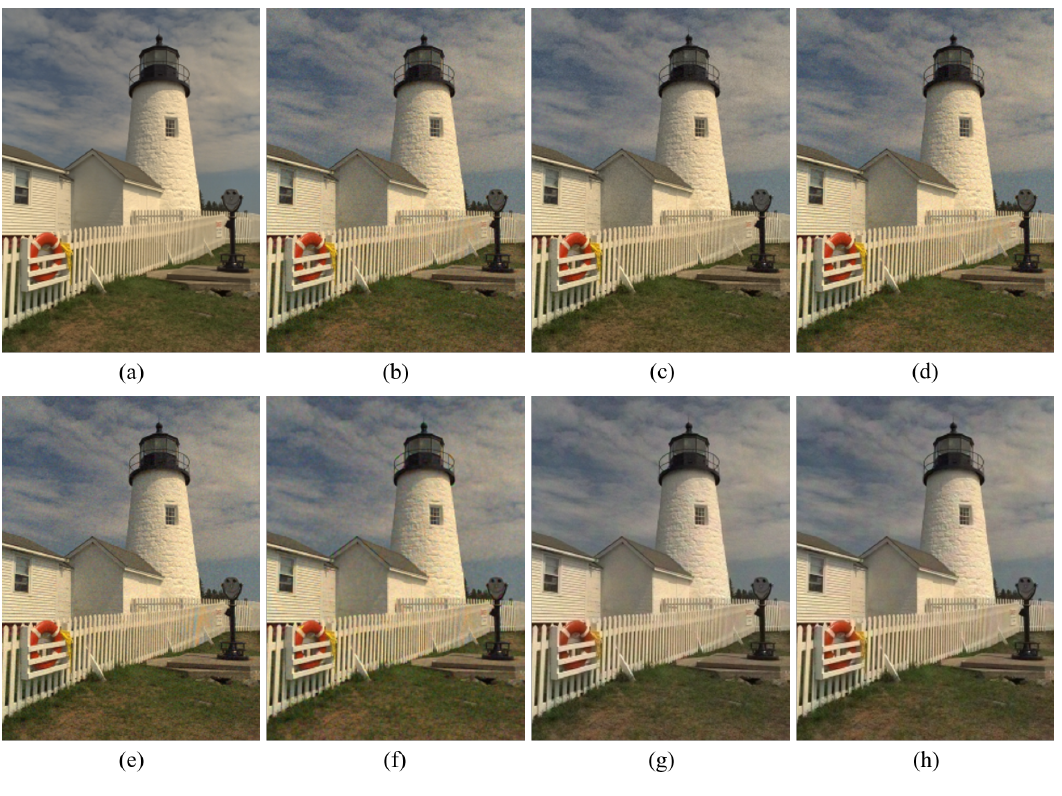
Figure 6. Demosaicing results of the Kodak No. 19 image under low-noise condition. ( a ) Original ( b )